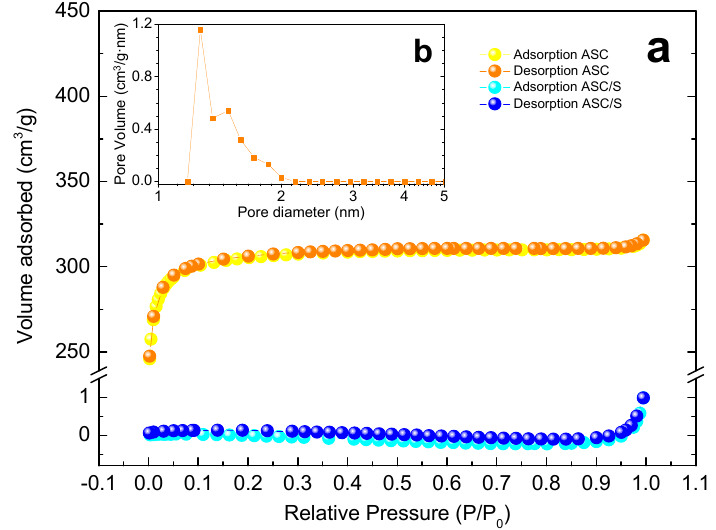
Figure 3. ( a ) Adsorption isotherm of nitrogen at 77 K for ASC and ASC/S composite; ( b ) density functional theory (DFT) plot for ASC is shown in the inset.